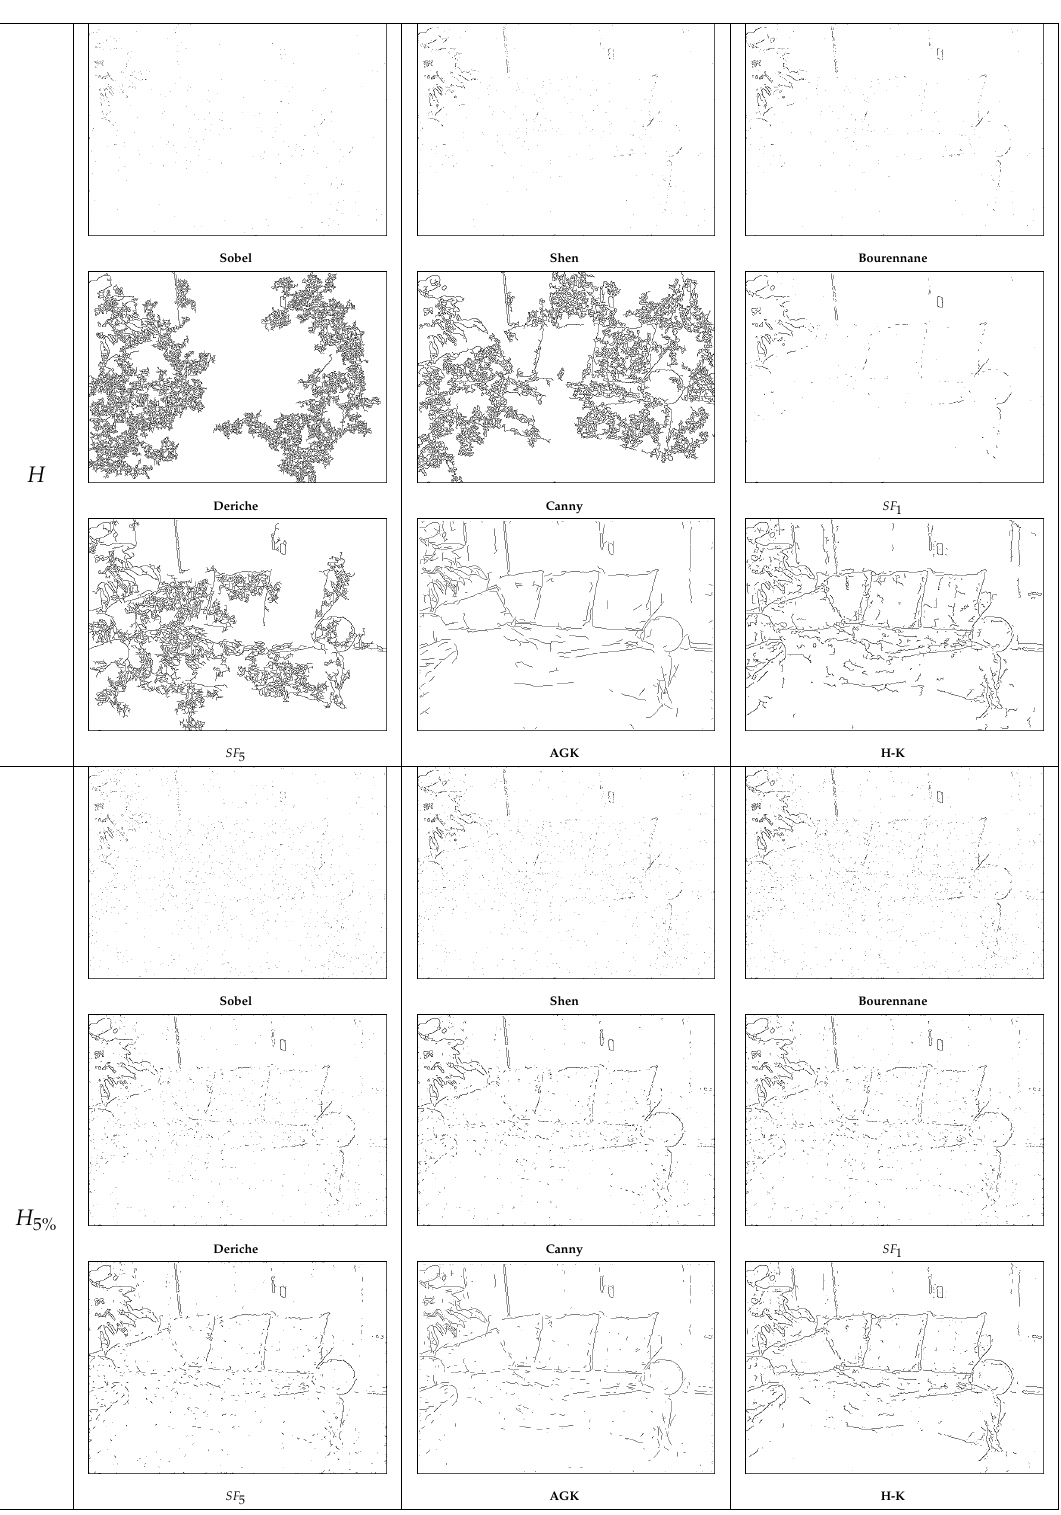
Figure 26. Ideal segmentations for several edge detectors on image 109, PSNR = 14